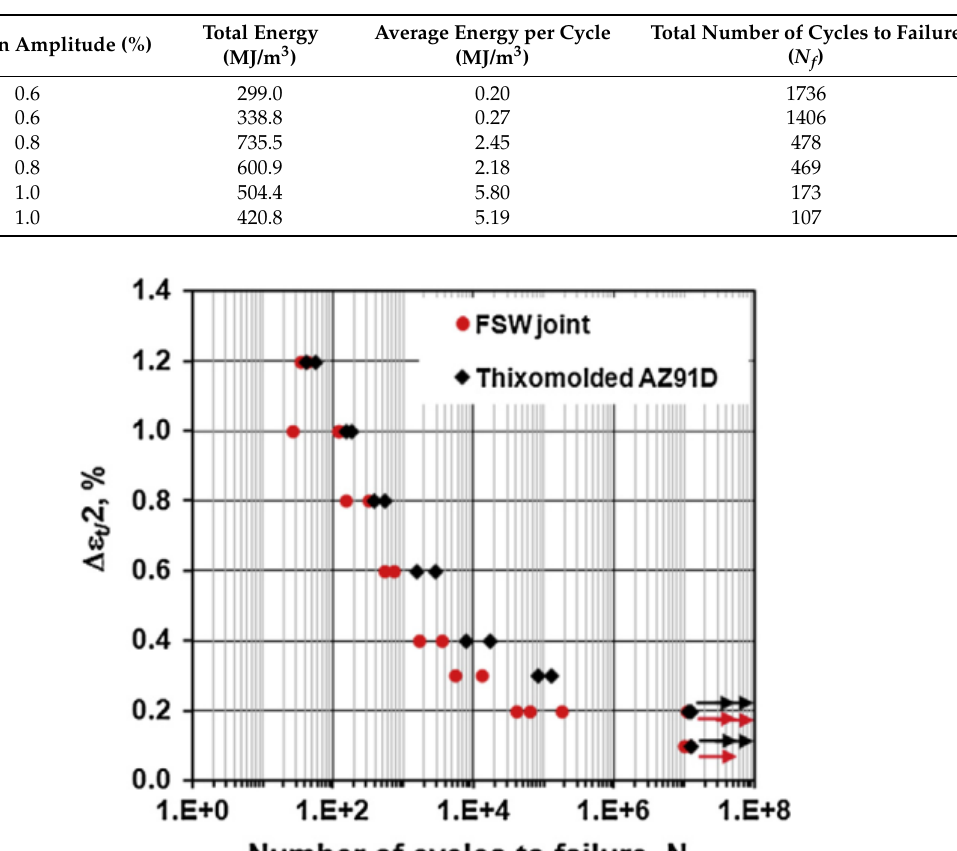
Figure 15. The plot of strain amplitude against the number of cycles to failure for the base metal and friction stir welded joint [91].